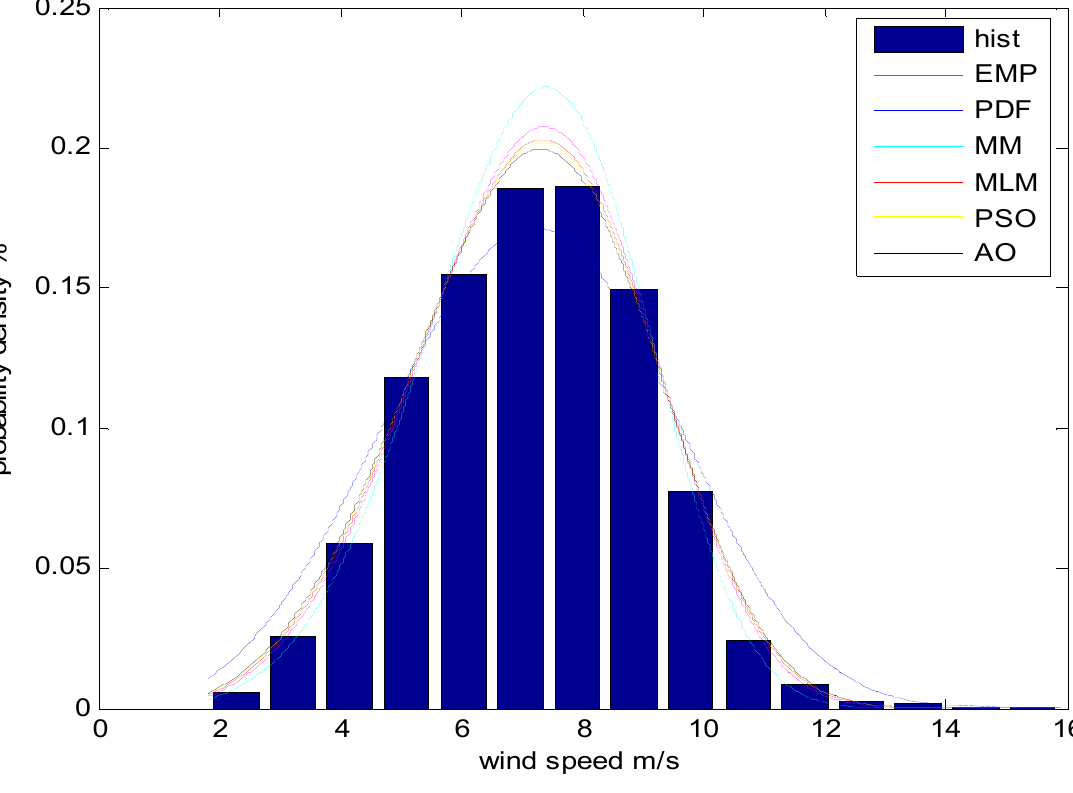
Figure 2. Weibull distributions: Zafarana site.